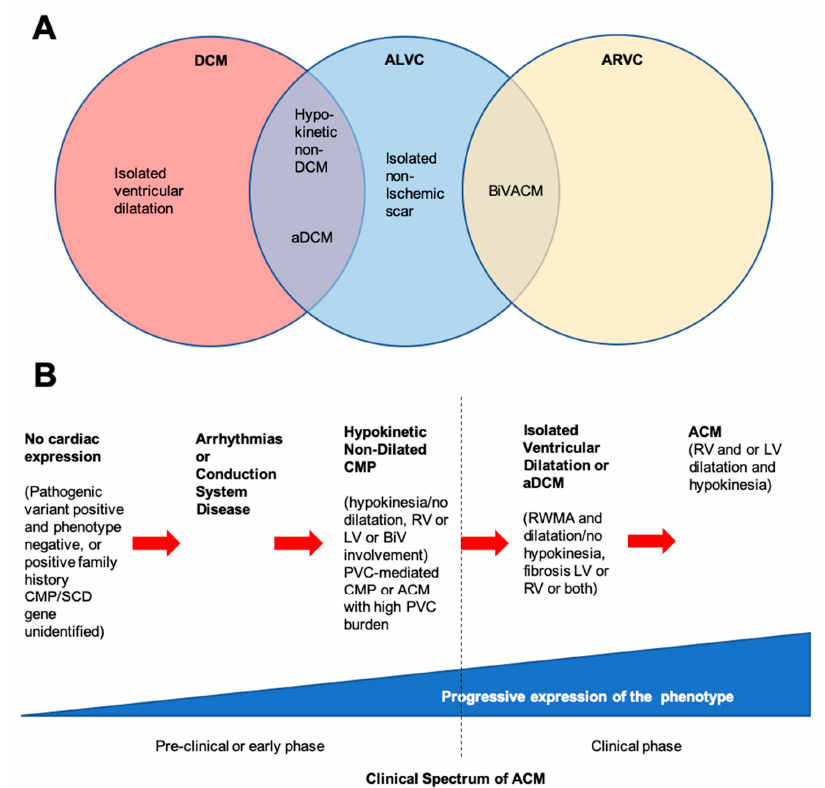
Figure 2. Spectrum of clinical presentations of right ventricular disease, left ventricular disease, and dilated cardiomyopathy. ( A ) ACM and ALVC show overlapping phenotypes with ARVC, but the